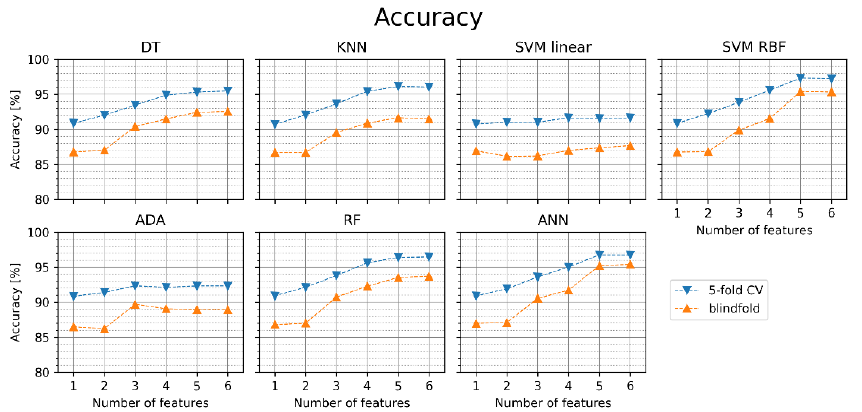
Figure 11. Accuracy of atrial fibrillation detection for different classifiers with sets of one to six features without pRR50 (orange points—blindfold validation, blue points—5-fold cross-validation). DT—decision tree, KNN—K nearest neighbors, SVM linear—support vector machine with linear kernel, SVM RBF—support vector machine with radial basis function kernel, ADA—Ada Boost, RF—random forest, ANN—artificial neural